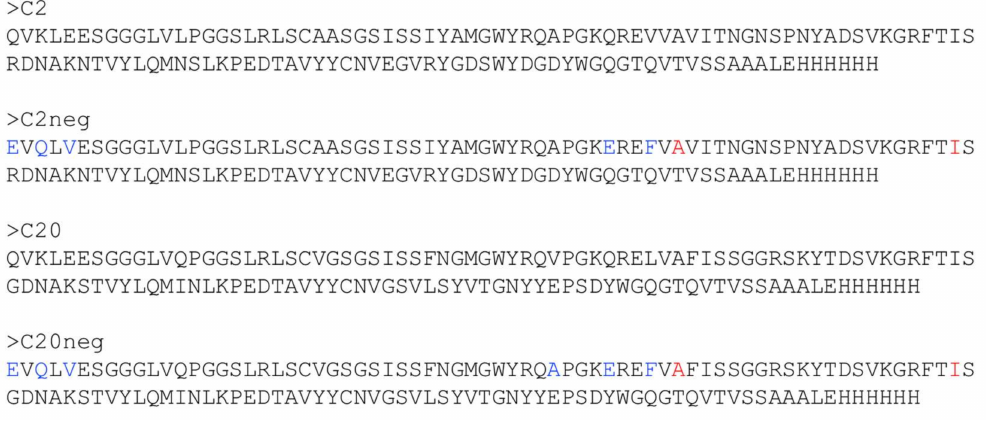
Figure 6. Overview of mutations introduced in V H Hs by Anderson et al. to improve the thermal stability of the C2 and C20 nanobodies [51]. The sequences of the wild-type antibodies C2 and C20 are shown. The sequences of the mutated C2neg and C20neg antibodies are also shown, with mutations highlighted in blue. Finally, C2neg and C20neg were further mutated by the introduction of additional disulphide bridges to form C2neg+ and C20neg+. This was accomplished by mutating the amino acids highlighted in red into cysteines. Adapted with the author’s